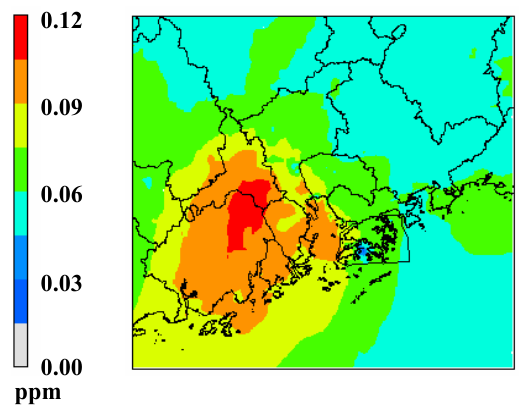
Fig. 6. Average hourly simulated surface O 3 at 15:00LST during October